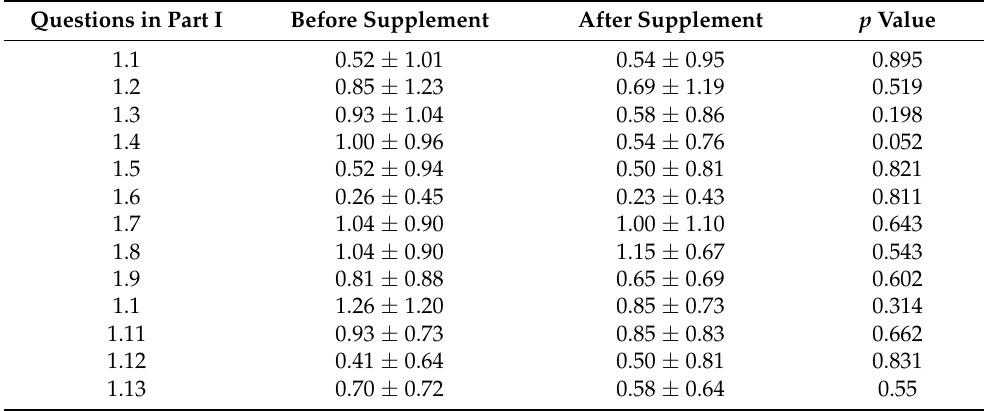
Table 5. Symptoms before and after oral zinc administration with MDS-UPDRS score Part